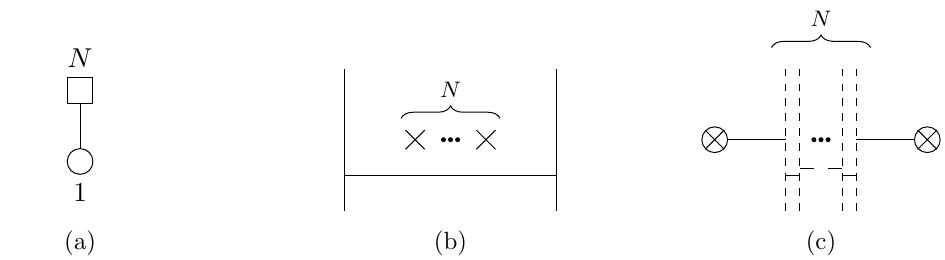
Figure 3. Model 3 d N = 4 SQED with N (cid:13)avors. (a) Quiver. (b) Coulomb branch brane con(cid:12)guration. There are N D5-branes. (c) Higgs branch brane con(cid:12)guration. In (c) a rotation with respect to (b) has been performed: the vertical direction corresponds with spatial directions ~y and the direction perpendicular to the paper corresponds with spatial directions ~x . Vertical dashed lines now represent D5-branes (there are N of them) and circled crosses represent NS5-branes.